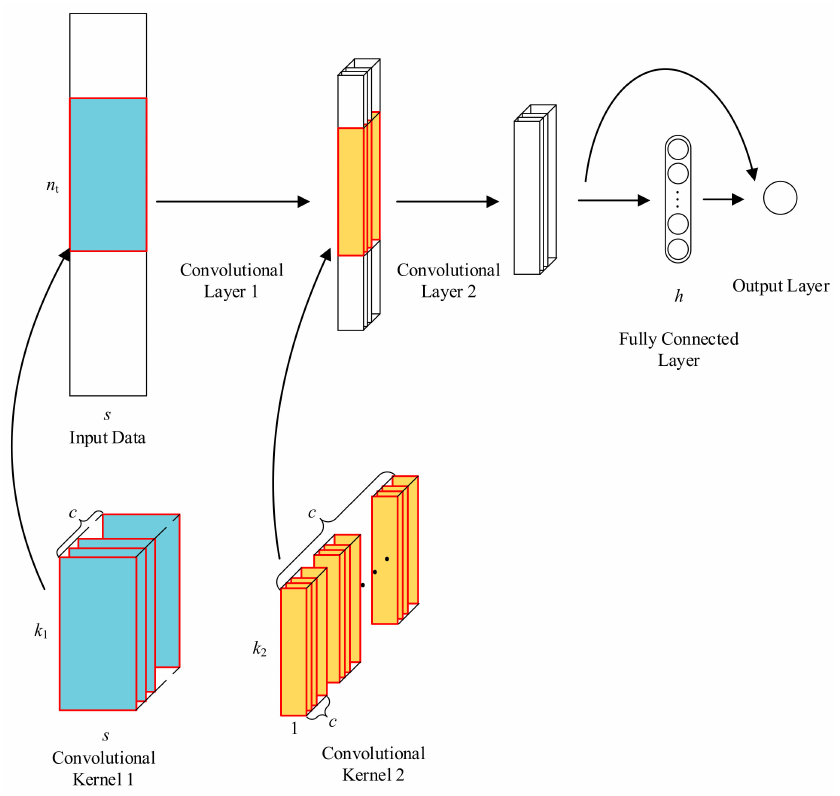
Figure 2. Architecture of the proposed response prediction model using convolutional neural